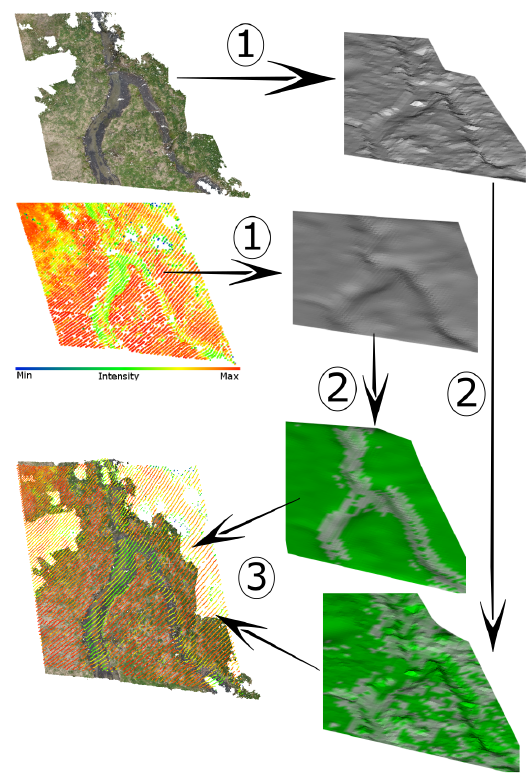
Figure 1. Scheme of the proposed approach. The arrows show the different steps for the registration, with start at the input point cloud: 1: surface reconstruction; 2: search for key planes; 3: the calculation of transformation parameters based on matched key planes and registration of input point